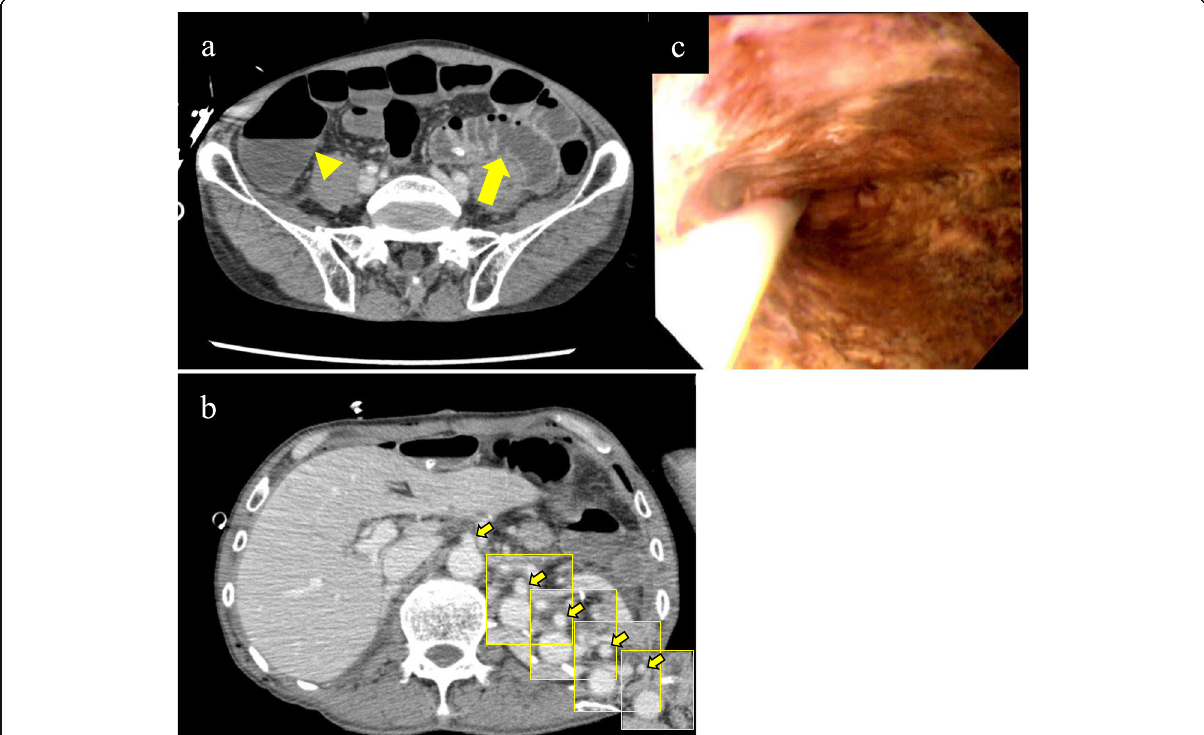
Fig. 2 Computed tomography (CT) and endoscopy at postoperative day 2 following esophagectomy. a CT revealed dilation of the small intestine (arrow) and large intestine (arrow head). We interpreted this finding as enteritis at first. b These images show slices of the superior mesenteric artery (SMA). CT revealed that there was no thrombus in the SMA (arrow). c Upper gastrointestinal endoscopy revealed ischemic changes in the mucosa over the entire circumference of the gastric tube from the anastomotic site to the